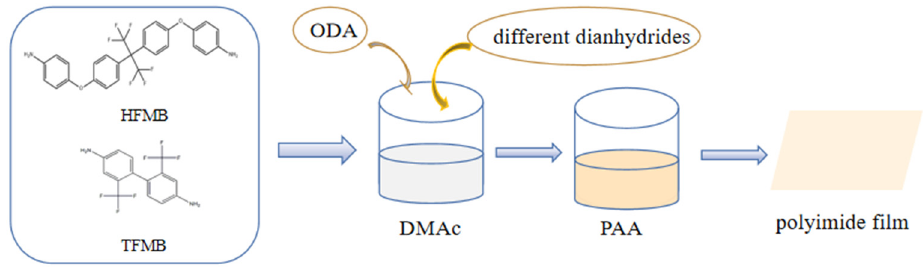
Figure 5. The synthesis process of fluorinated polyimides.